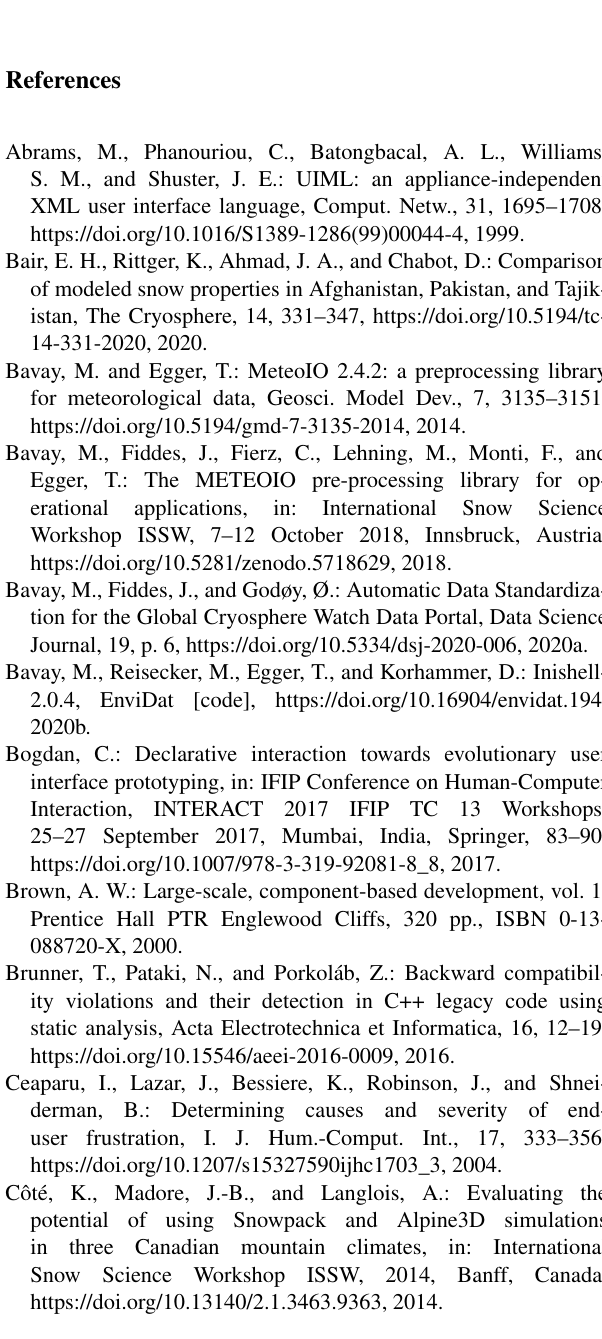
Figure A1. Syntax of the INI file with numbered